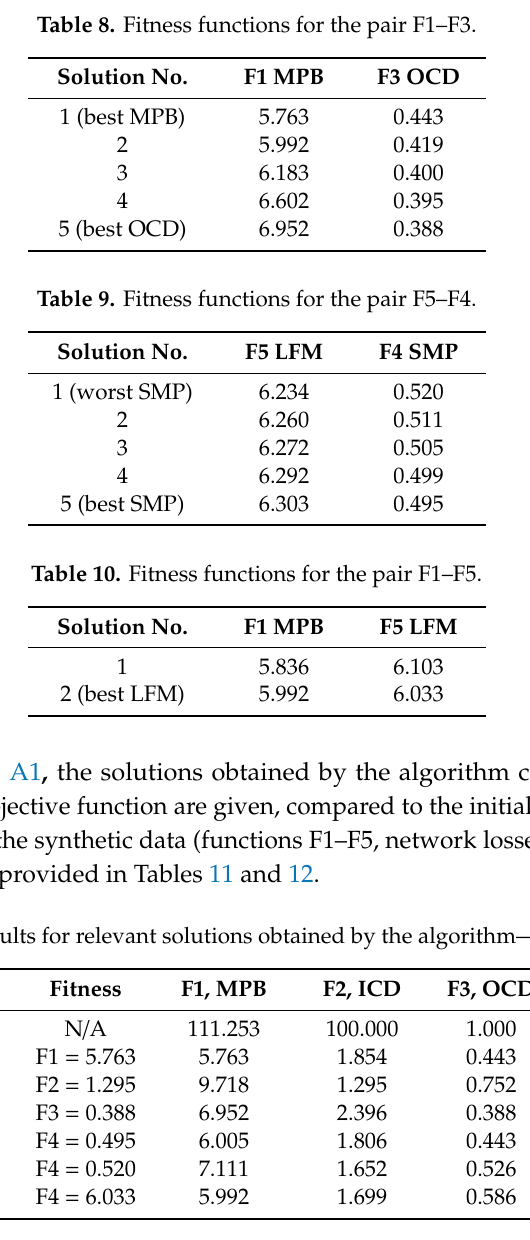
Table 12. Detailed results for relevant solutions obtained by the algorithm—network